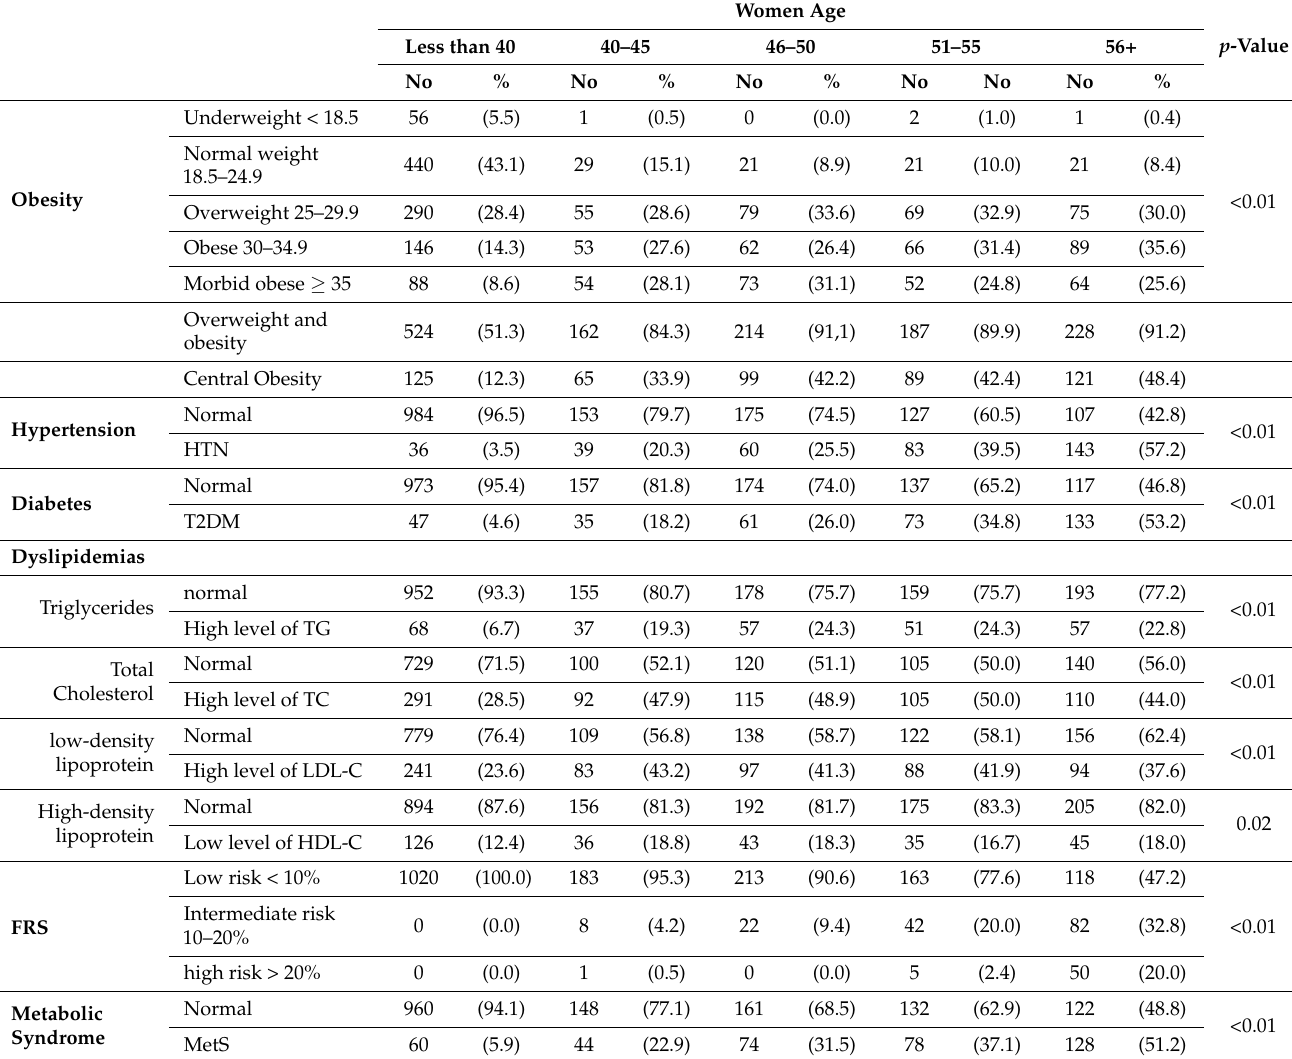
Table 2. Cardiometabolic profile of the studied sample among different age